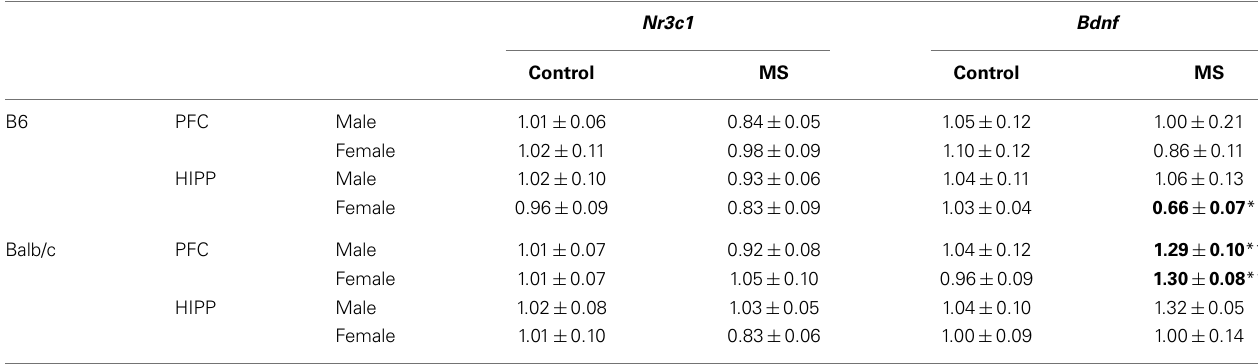
Table 2 | Relative mRNA levels of Nr3c1 and Bdnf in the prefrontal cortex (PFC) and hippocampus (HIPP).